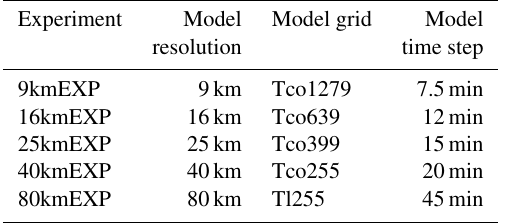
Table 2. List of simulations with different resolutions given by dif- ferent model grids. All simulations use 137 vertical model levels. All the experiments have been performed in January and July 2014 using the same CO 2 surface fluxes (see Table